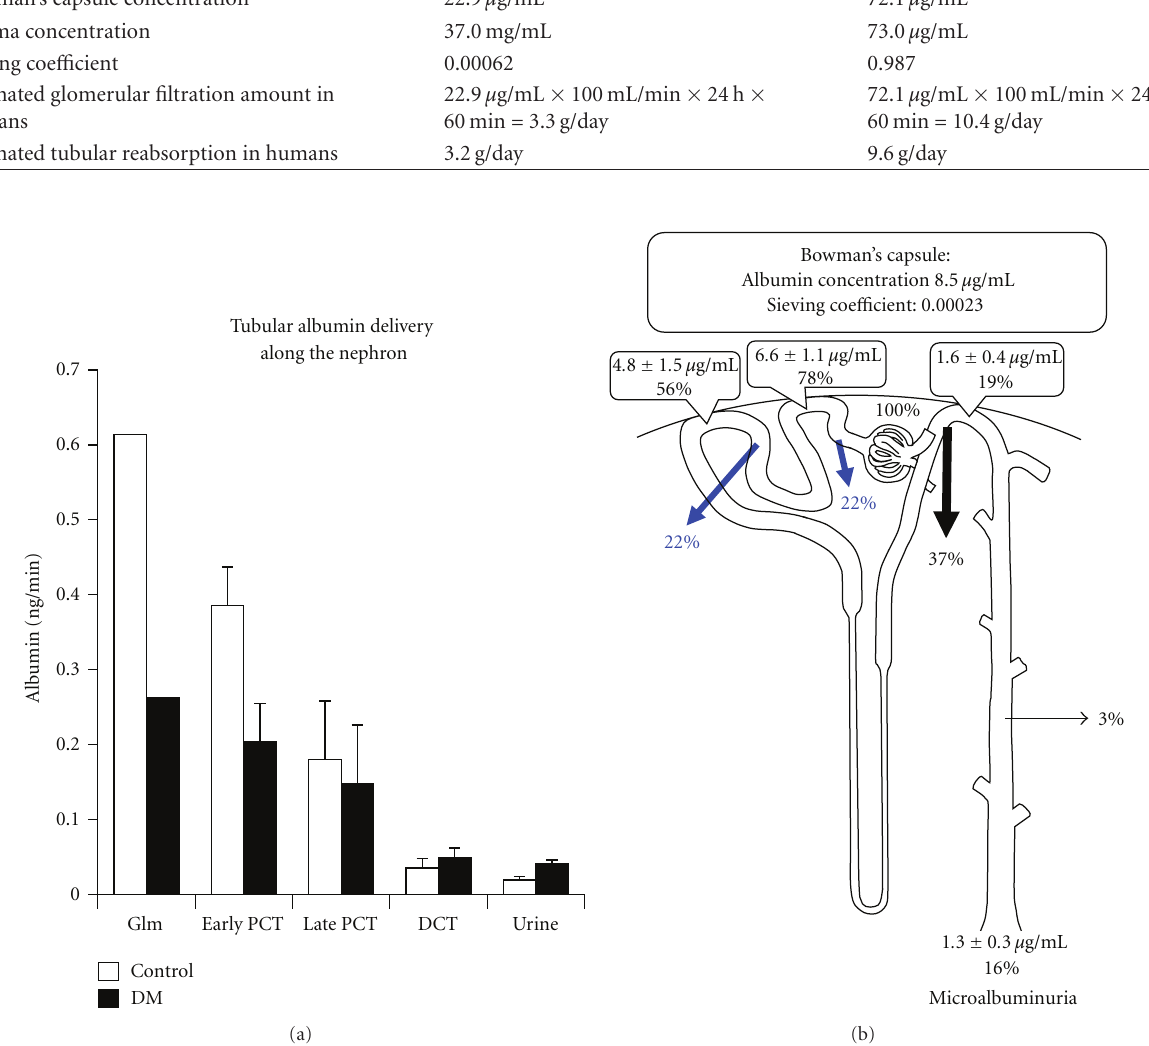
Figure 2: Tubular albumin reabsorption in diabetic nephropathy calculated from the data from a rat fractional micropuncture study. Albumin reabsorption in the proximal convoluted tubules (PCT) is significantly reduced in diabetes mellitus (DM) rats, resulting in higher albumin delivery in the distal convoluted tubules (DCT) and urine in DM rats than in normal controls.